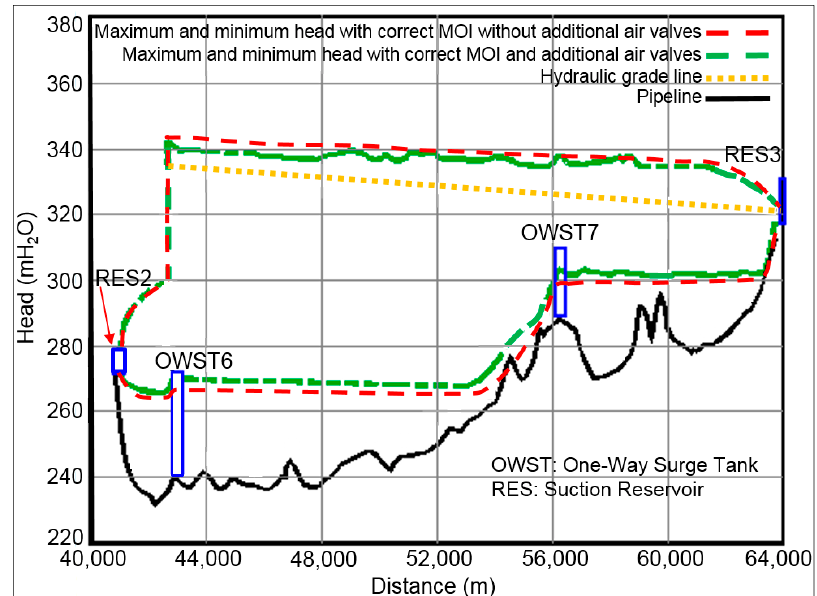
Figure 10. Maximum and minimum head envelopes for the third pipeline segment with and without additional air valves and the correct moment of inertia (MOI), following the simultaneous power failure of the two pumps at Pumping Plant 3.